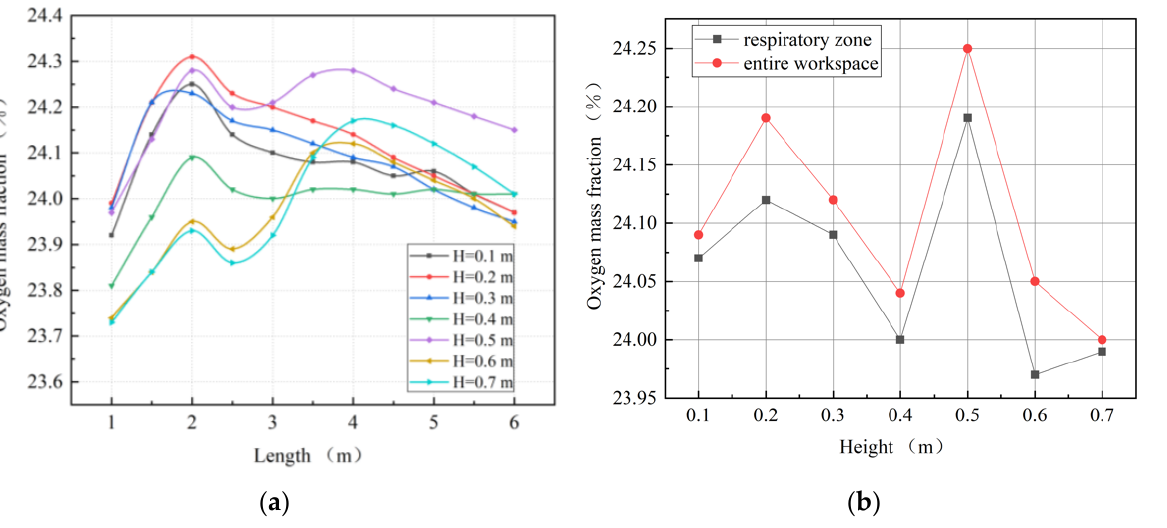
Figure 12. Characteristic diagram of oxygen mass fraction distributions in the main working area. ( a ) Oxygen mass fractions along the roadway; ( b ) oxygen mass fractions in the respiratory zone and in the entire workspace.